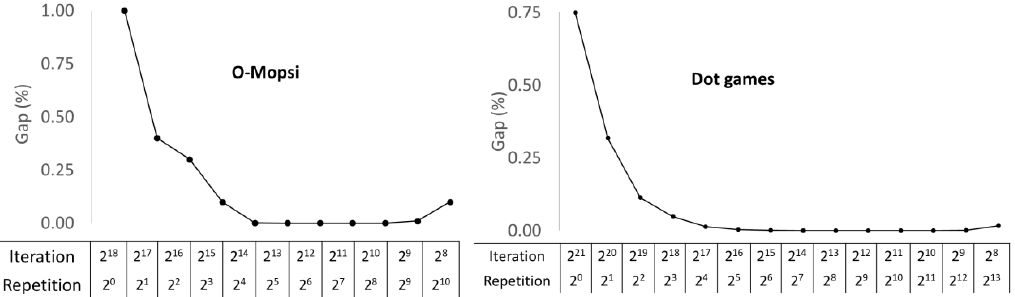
Figure 20. Gap variation with varied iterations and repetitions.